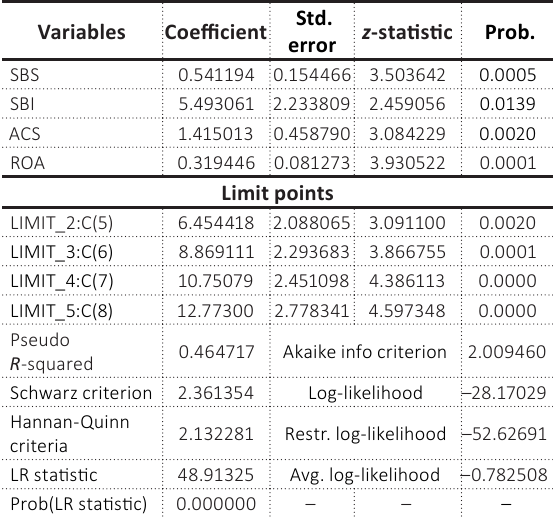
Table 4. Estimation result of the ordered probit regression model: the impact of supervisory board size and independence, audit committee